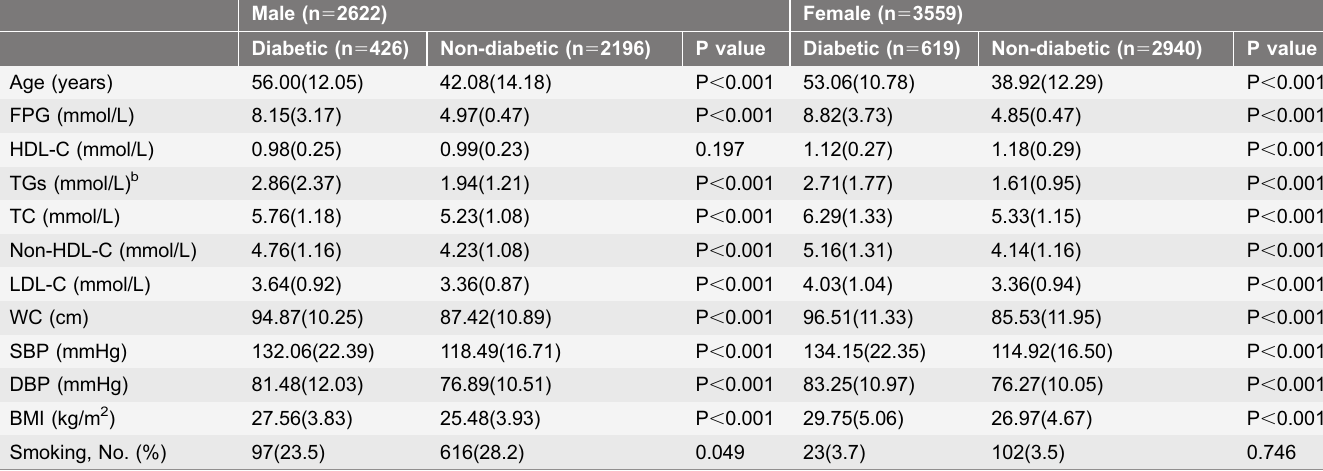
Table 1. Baseline characteristics of participants by gender and diabetes status a ; Teheran Lipid and Glucose Study (March 1999- December 2011).